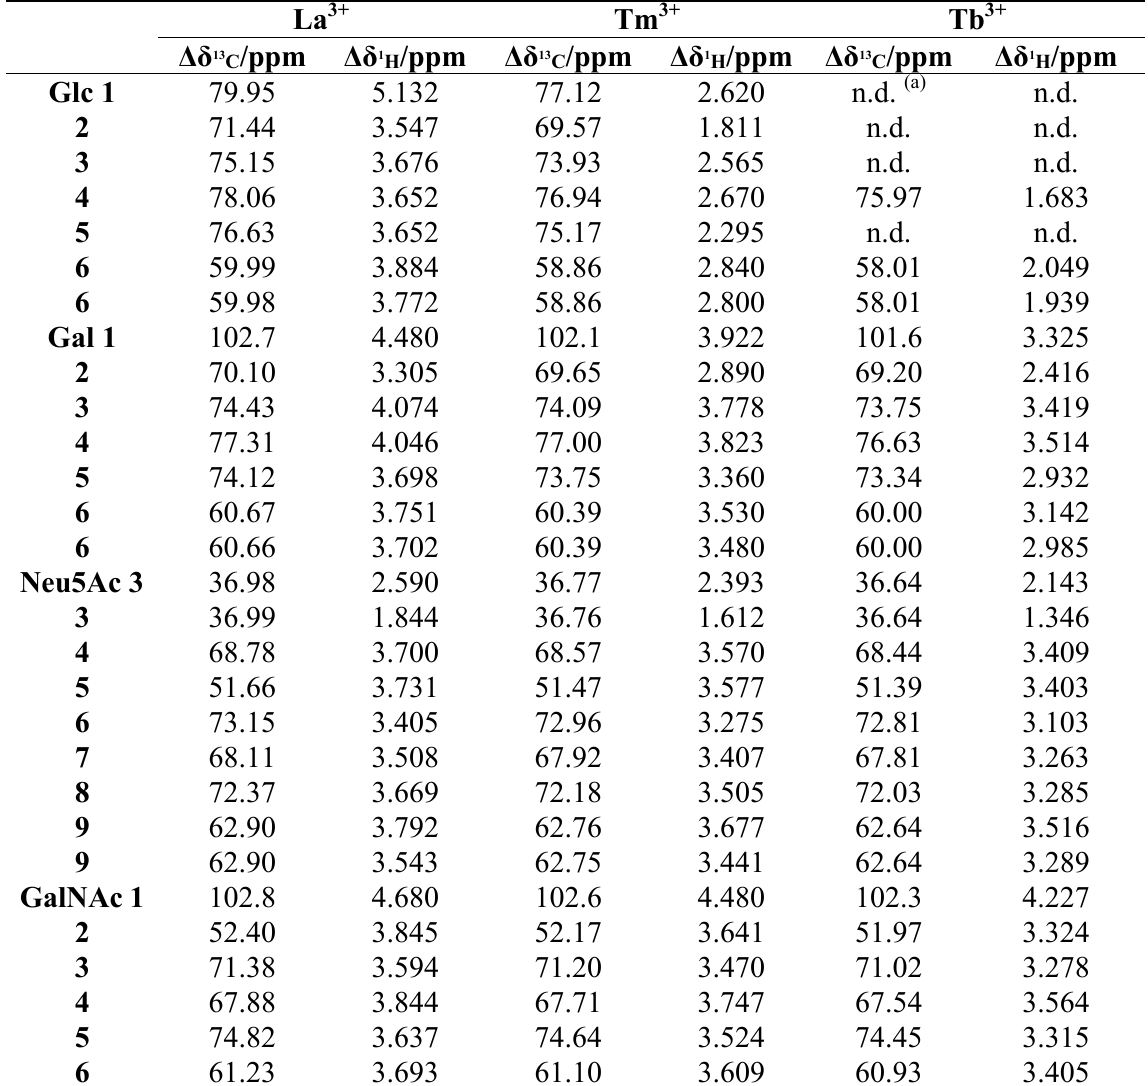
Table 1. 1 H and 13 C chemical shifts of the GM2 tetrasaccharide tagged with La 3+ , Tm 3+ , and Tb 3+